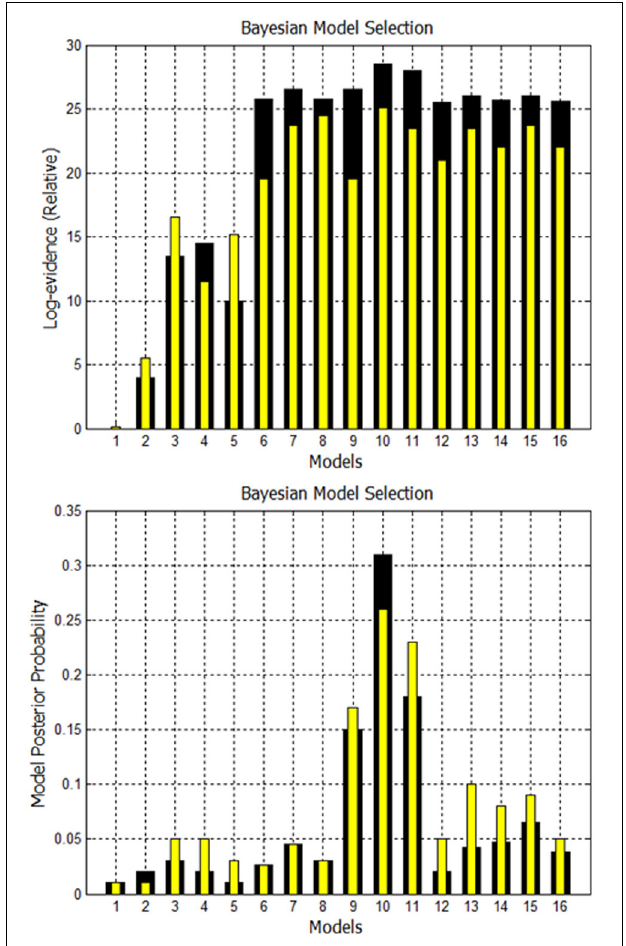
FIGURE 8 | Comparison of FFX analysis for Go/No-Go dataset for two techniques. Black bars are for estimation of missing nodes with EM for this one subject. Yellow bars are for using the higher p -values to get the missing nodes. Model 10 has highest evidence in both cases, but other competing models are getting closer.